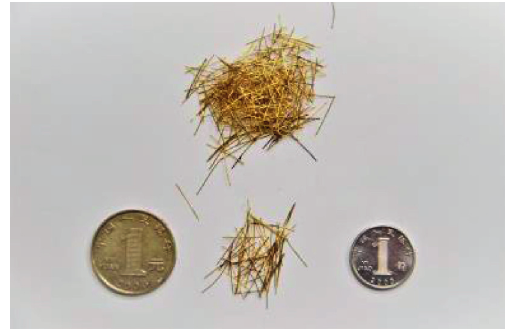
Figure 3: Type I (smooth cold-drawn wire) microsteel fiber.